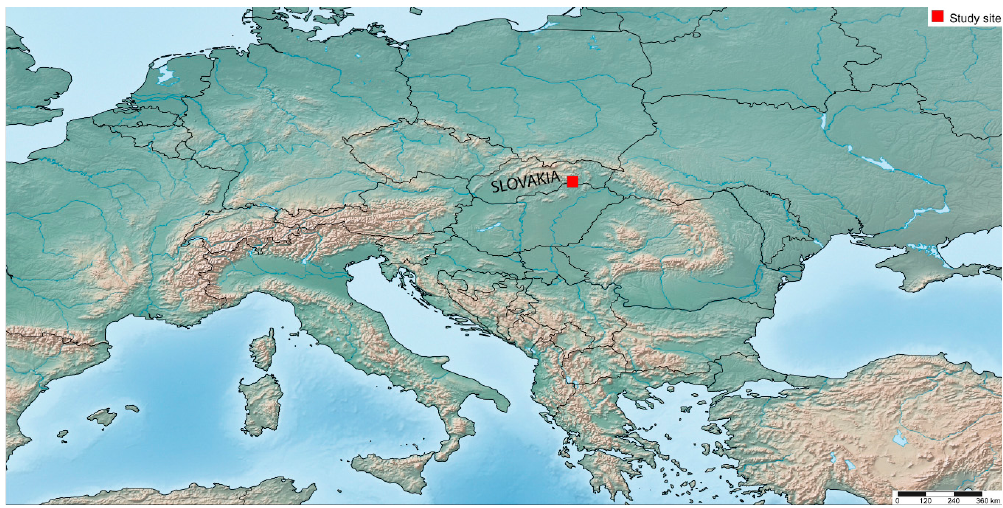
Figure 1. Study site location in south-east Slovakia. Map was plotted using SimpleMappr.